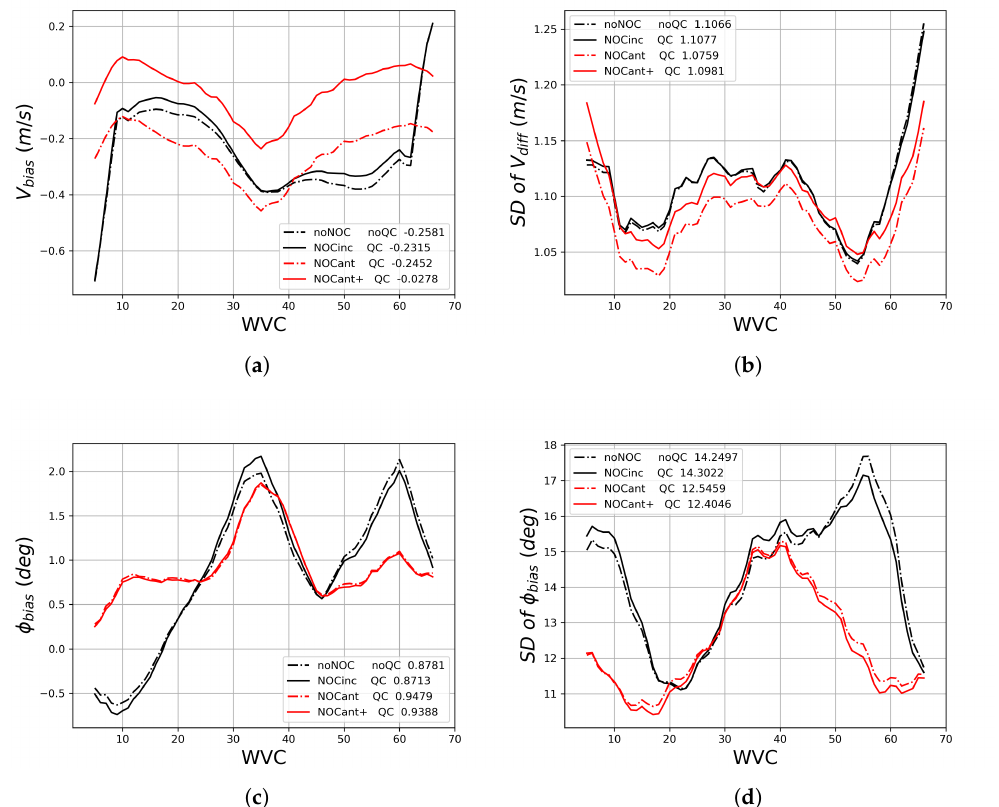
Figure 17. C-band ascending orbits wind retrieval statistics as a function of WVC with noNOC, NOCinc, NOCant, NOCant+. The mean numbers of each condition are stated beside each legend, data from 1–9 March 2022: ( a ) wind speed bias, ( b ) wind speed SDD, ( c ) wind direction bias, ( d ) wind direction